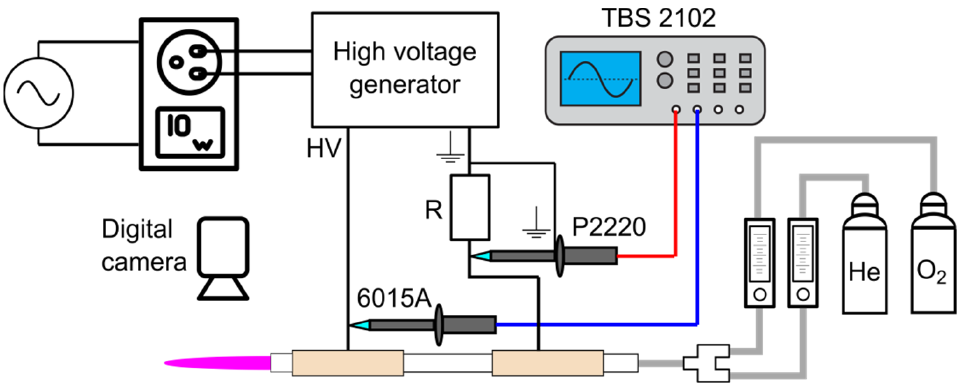
Figure 2. Experimental setup for measuring electrical quantities.